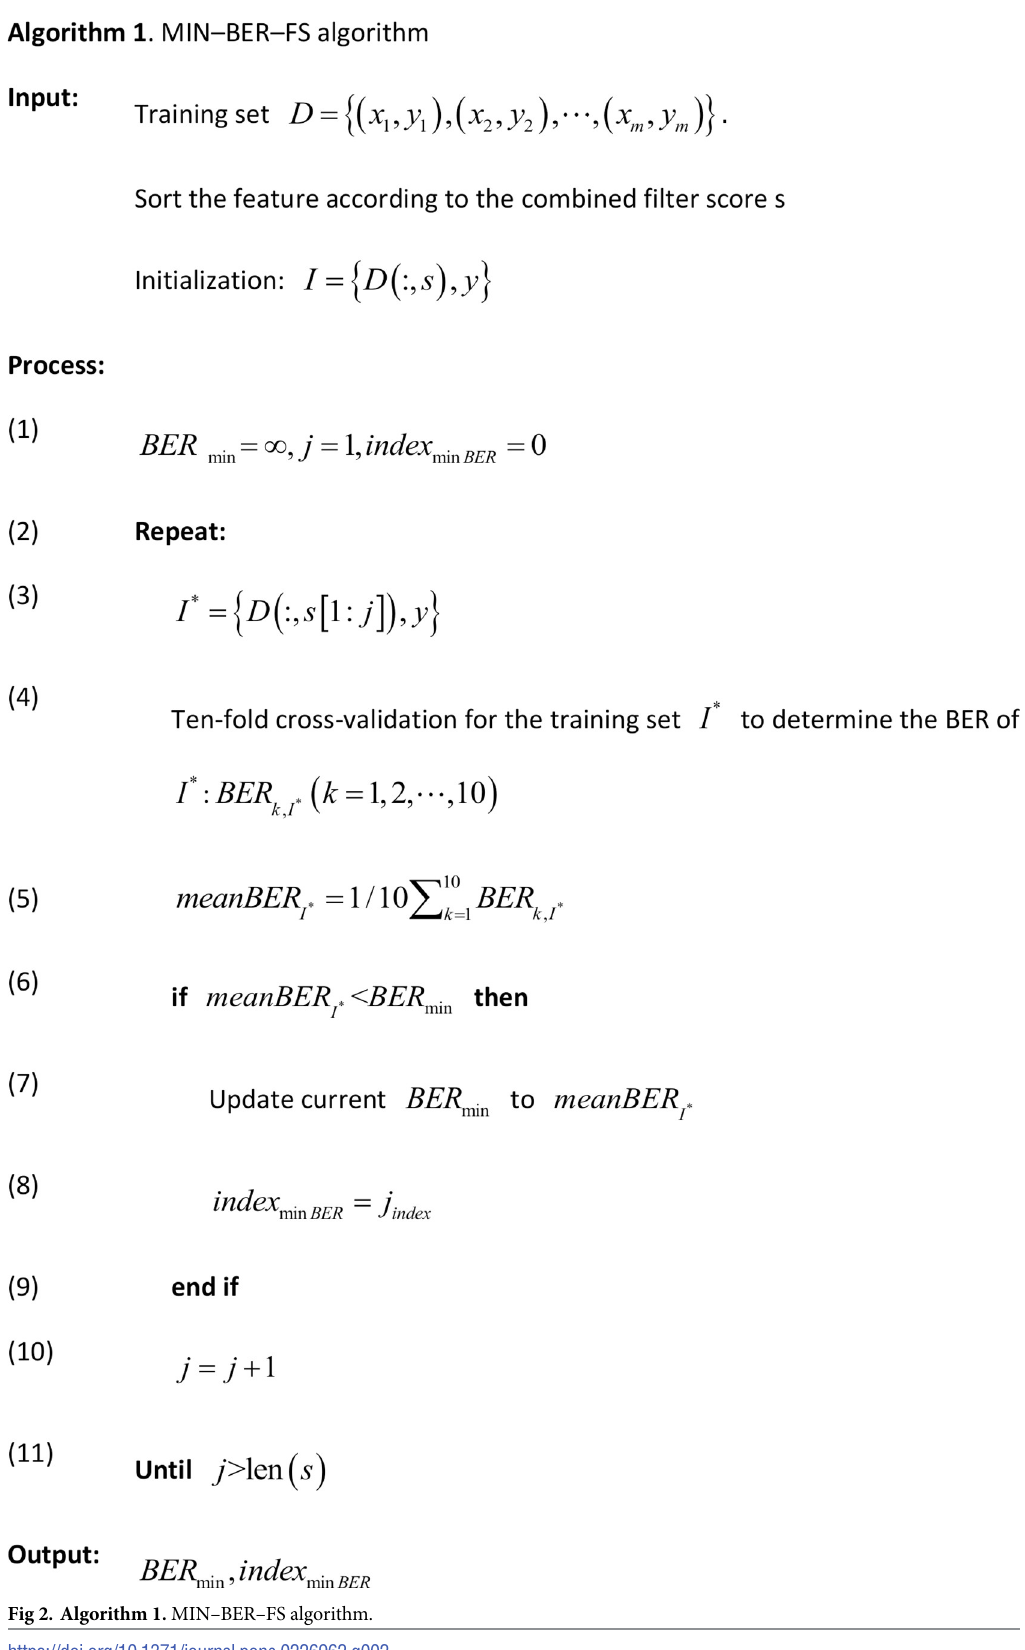
Fig 2. Algorithm 1. MIN–BER–FS